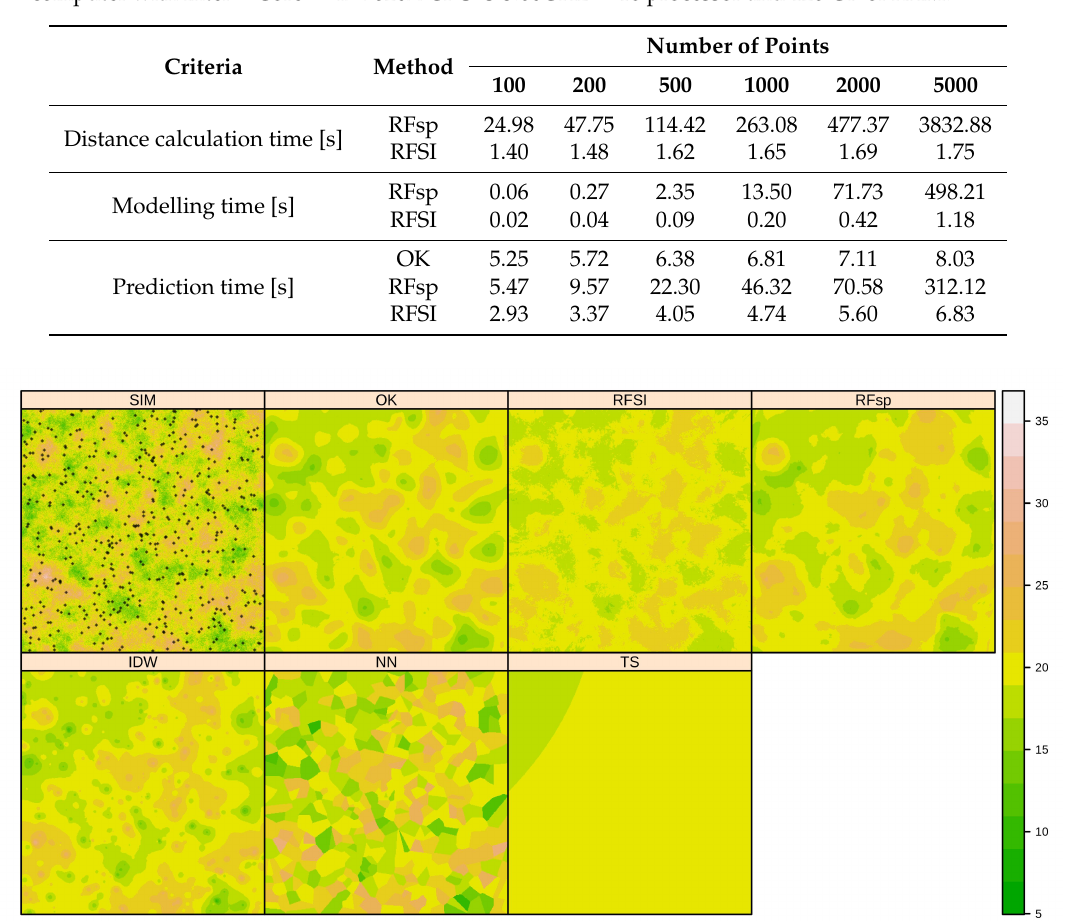
Figure 5. Prediction maps made using 500 sample locations with nugget-to-sill ratio 0.25 and range 50, for one of the 100 simulated realities. The top left map (SIM) shows the simulated reality and the locations of the 500